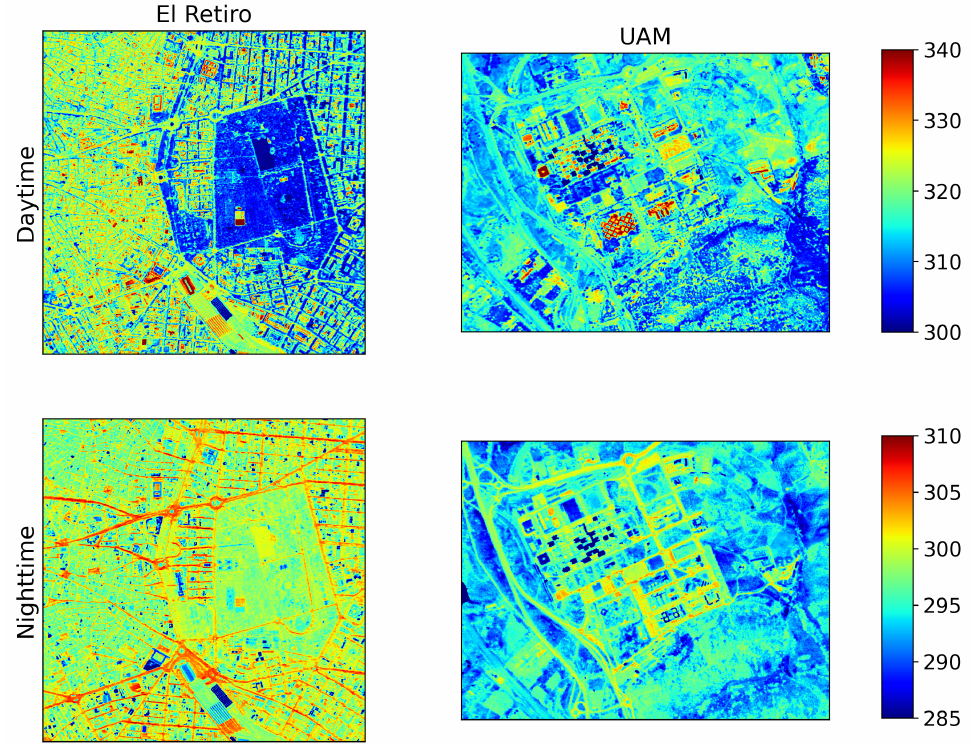
Figure 11. LST in K retrieved from the 2MMD-4-band TES over the Retiro Park ( left ) and the UAM ( right ) during the daytime ( top ) and nighttime ( bottom